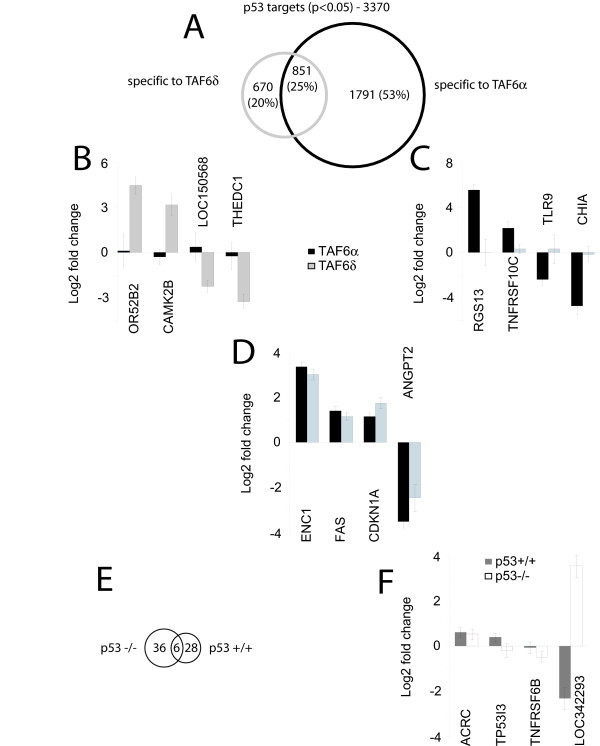
Evidence for transcriptional crosstalk between endogenous TAF6δ and p53. (A) Venn diagram illustrating the partitioning of previously characterized p53-regulated genes [5] into TAF6α and TAF6δ dependent classes. (B) Examples of TAF6δ but not TAF6α dependent p53 target genes. Log base 2 fold changes in gene expression are shown graphically. Error bars show the standard deviations over three independent experiments and gene symbols are shown at the bottom. (C) Examples of TAF6α but not TAF6δ dependent p53 target genes (as in panel B). (D) Examples of TAF6α and TAF6δ dependent p53 target genes (as in panel B). (E) Previously characterized TAF6δ target genes [5] partition into p53 dependent and independent genes as illustrated with Venn diagrams. (F) Examples of p53 dependent and independent TAF6δ target genes (as in panel B).